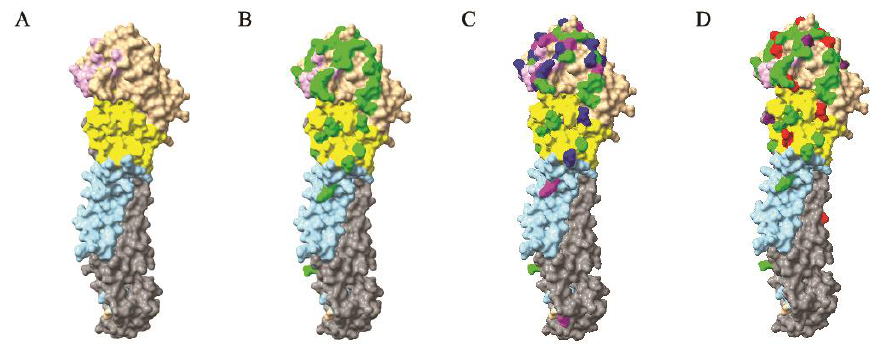
Figure 2. Antigenic variation, positive selection, and glycosylation in the 2016–2019 Mexican H5N2 AIVs mapped onto one H5 HA protomer. The H5 HA crystal structure is manipulated with Chimera and shown in the surface format using the structure from A/Vietnam/1203/04 (PDB #2FK0). ( A ) The globular head consists of the receptor-binding domain (RBD, tan, aa 110–262) and vestigial esterase domain (VED, yellow, aa 42–109, aa 263–272). The stalk domain contains regions of the N-terminus (aa 1–41) and the C-terminus of HA1 (sky blue, aa 273–330) and a membrane-proximal helix-rich region of HA2 (gray, aa 384–515). The receptor-binding site is shown in plum (HA1 129–133, 184–186, 217–224). ( B ) The known antigenic residues are shown in green. ( C ) The antigenic variations identified in the H5 HA protein of the 2016–2019 Mexican H5N2 AIVs against the HA protein of the two vaccines, A/chicken/Guanajuato/CPA-20966–15-VS/2015 (gene accession no. MH158232) and the recombinant NDV vector vaccine strain A/chicken/Mexico/435/2005 (gene accession no. FJ864690), are shown in magenta. Amino acid substitutions found in > 90% isolates are shown in blue. ( D ) Positively selected residues in the H5 HA protein of the 2016–2019 Mexican H5N2 AIVs are shown in red, and three glycosylated residues (aa 84, aa 126, and aa 162) found in later viruses but not early viruses are shown in purple. H5 numbering is used for amino acid posi- tion.